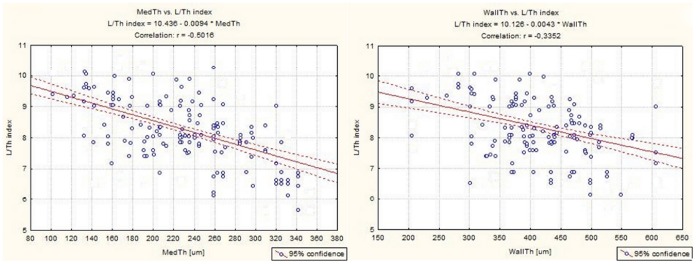
Association between SV wall or tunica media thickness and the SMC nuclei shape.The moderate negative correlations were found between the shape of the SMC nuclei (L/Th index, length/thickness index) and both MedTh (Fig. 3a) and WallTh (Fig. 3b).